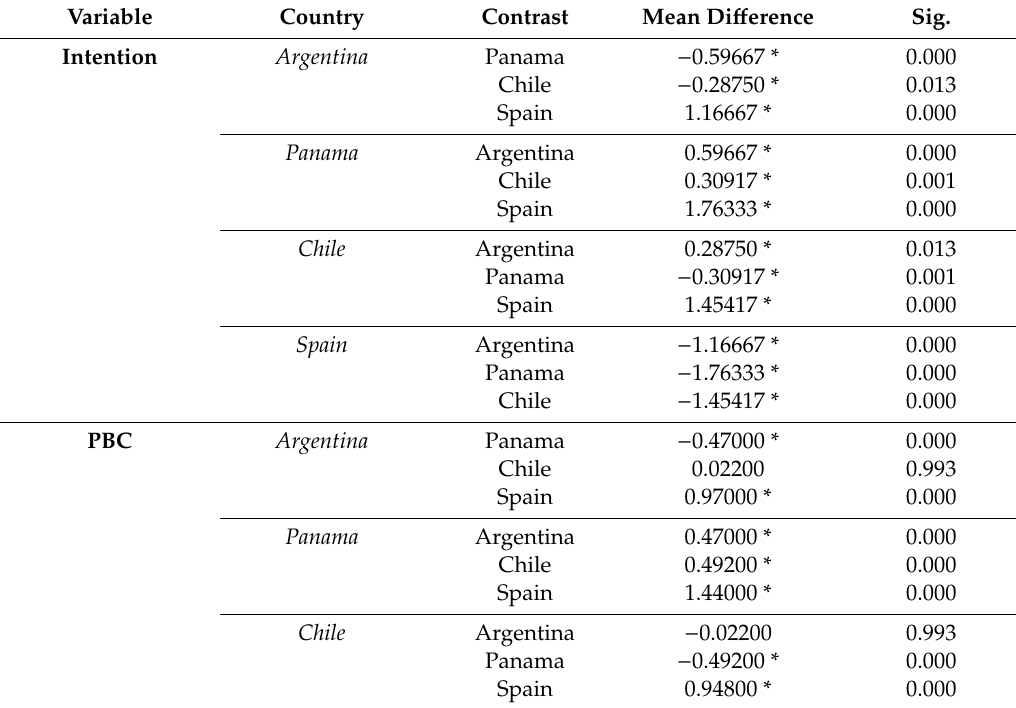
Table 5. Post-Hoc